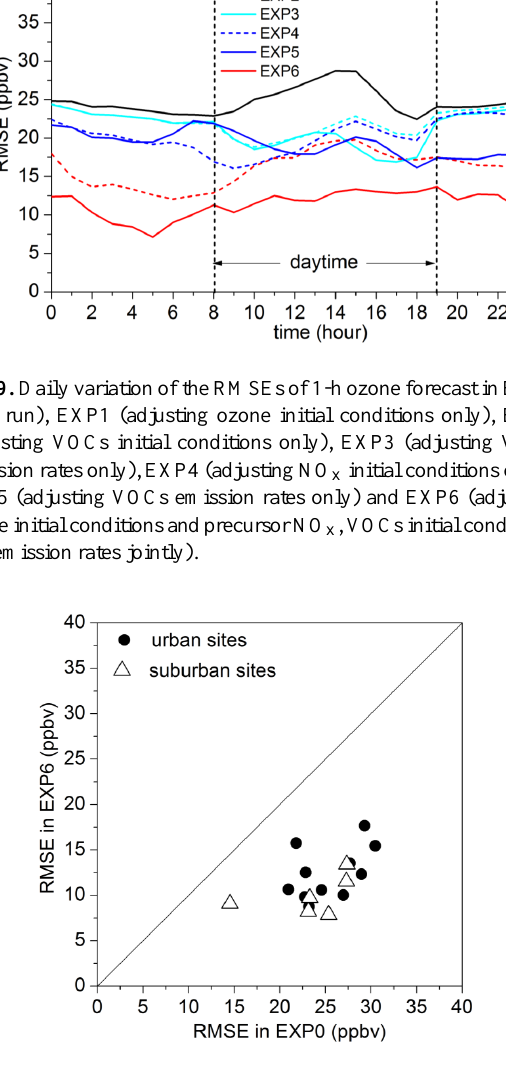
Fig. 10. Comparison of RMSE of 1-hour ozone forecast at urban sites (dots) and suburban sites (triangles) in free run against those in EXP6.